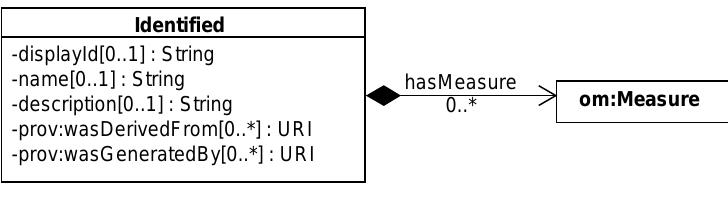
Figure 5: Diagram of the Identified abstract class and its associated